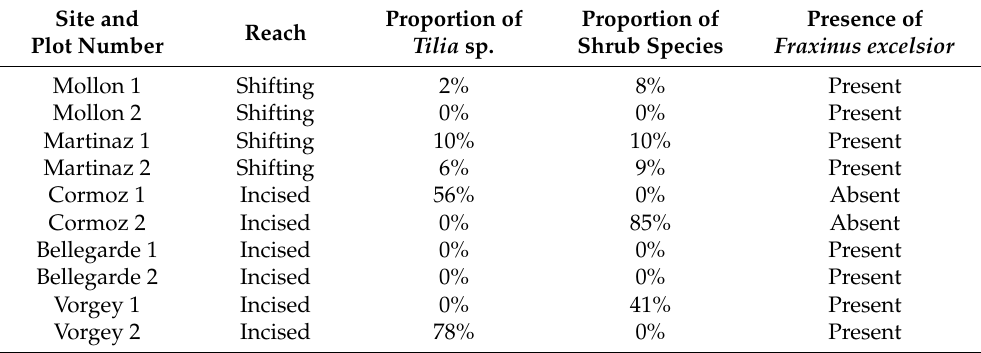
Table 5. Example species distributions from the vegetation survey conducted by the EVS laboratory along the vertical gradient (70 y.o.) for plots in both the shifting reach and incised reach. Site and Plot Proportion of Reach Number Tilia sp.